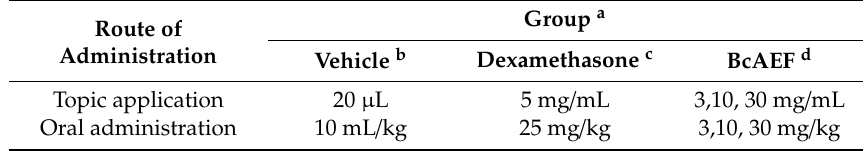
Table 2. Group distribution in the croton oil induced ear edema assay in